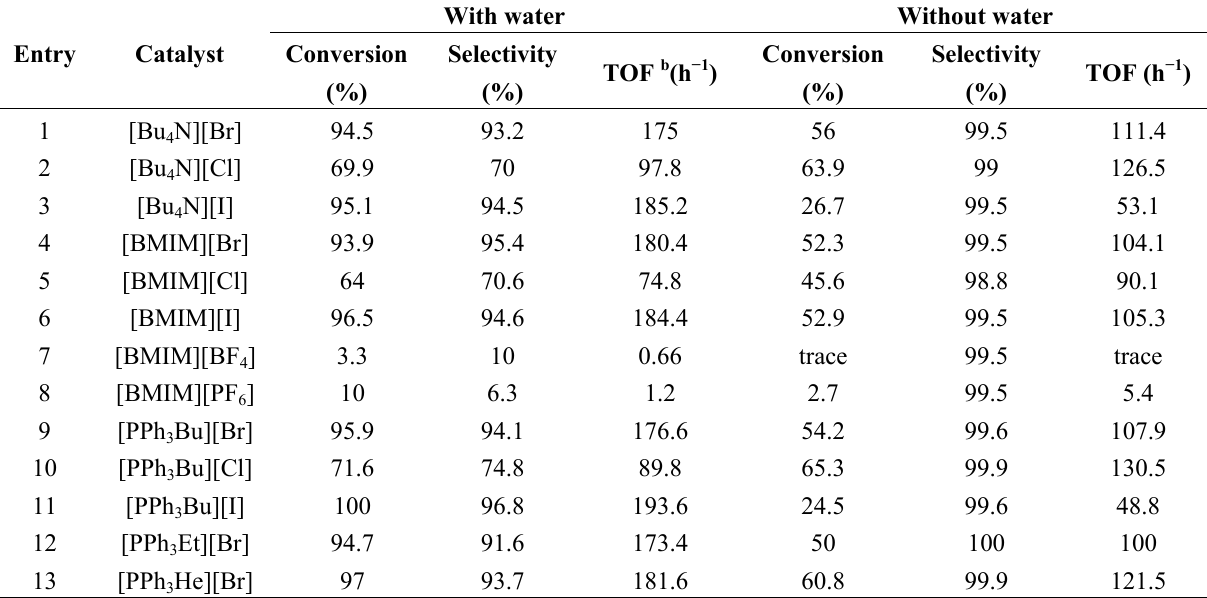
Table 8. Comparison of cycloaddition of PO to PC catalyzed by ILs with and without water a